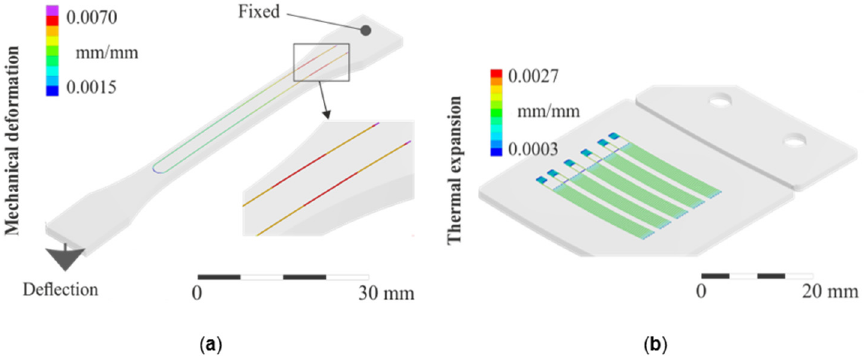
Figure 9. Simulation of the equivalent strain ( a ) during mechanical deformation and ( b ) during heating.